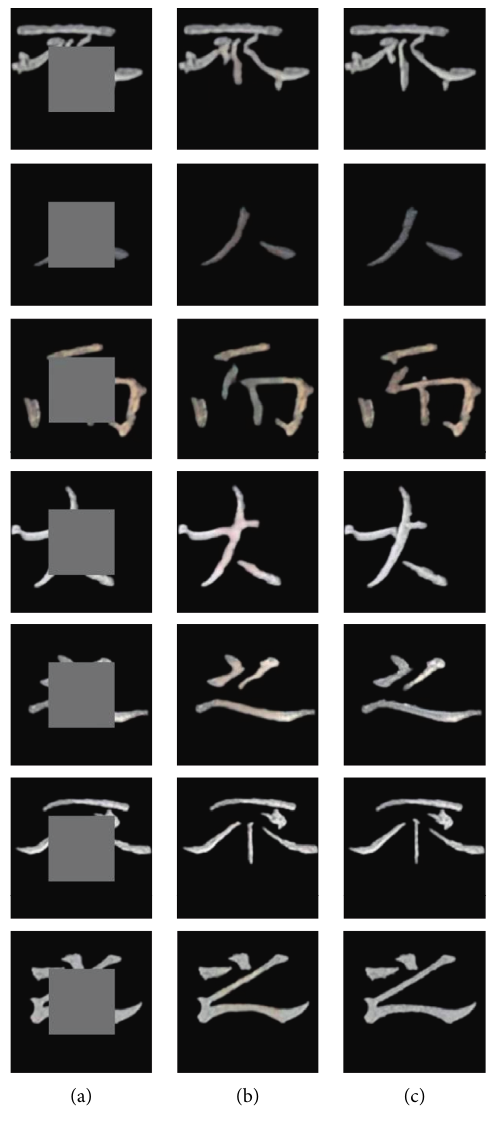
Figure 10: Stone inscription image inpainting results. (a) The input images with masks. (b) The inpainting results. (c) The